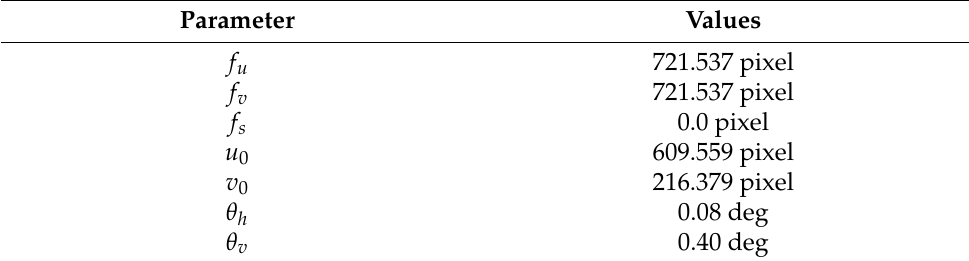
Table A1. Intrinsic parameters of LiDAR-camera system in the KITTI outdoor dataset